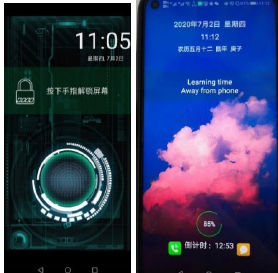
Figure 1. Goodware applications have the function of locking